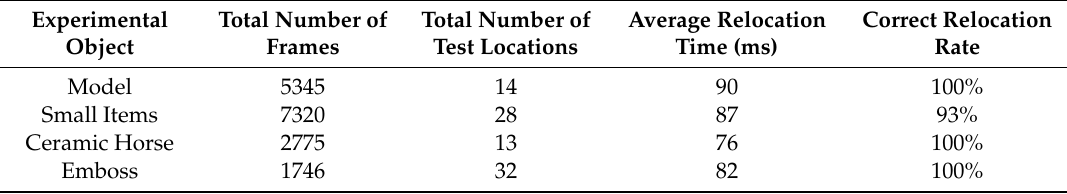
Table 2. Result statistics of online